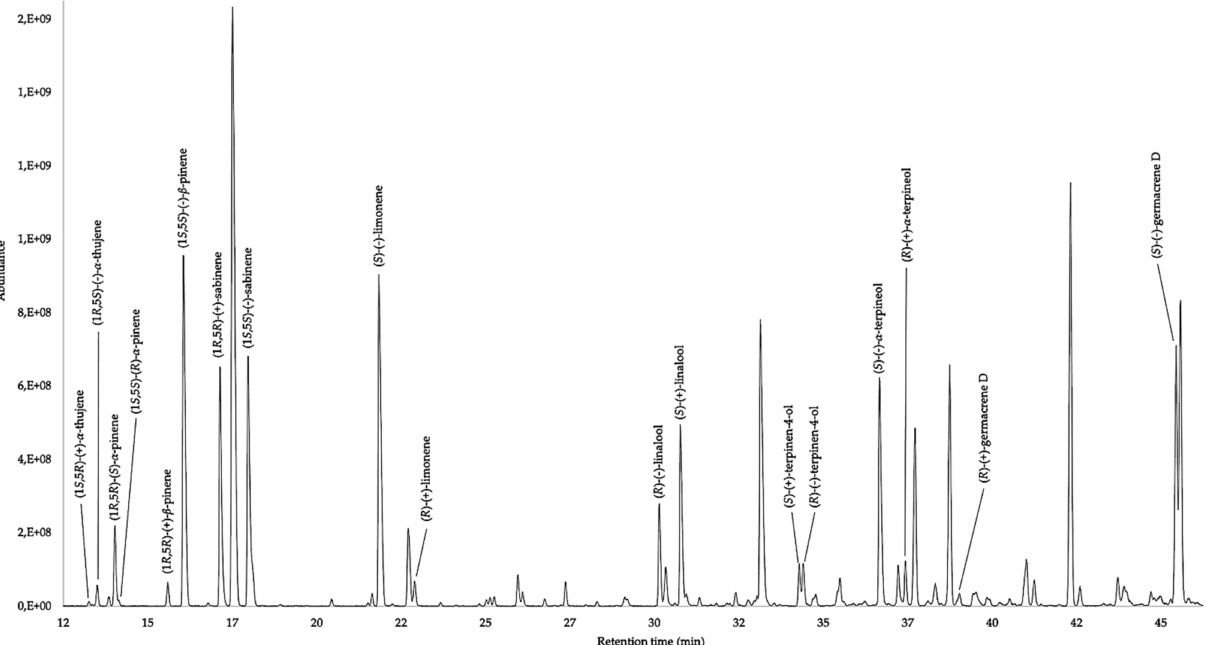
Figure 1. Enantioselective chromatogram of C. taxifolium EO on 30% diethyl-tert-butyldimethylsilyl- β -cyclodextrin/PS-086